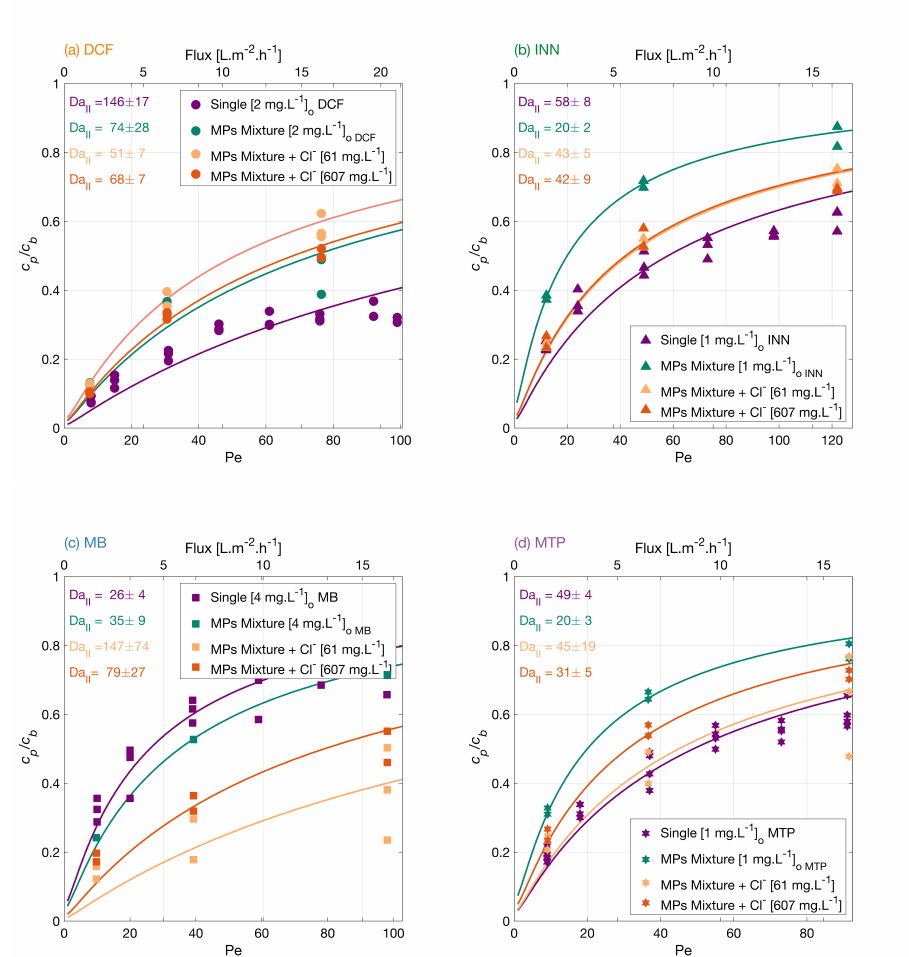
Figure 5. Degradation of ( a ) DCF, ( b ) INN, ( c ) MB, and ( d ) MTP independently, in a mixture and in a mixture with two concentrations of chloride ions. Symbols depict experimental results, and lines correspond to the mass transport and surface reaction model. Conditions: the legend shows the feed concentrations [ c b ] o , 366 nm radiation, 210 W · m − 2 and 142 mg · L − 1 Na 2 SO 4 for the experiments with the MPs independently and in a mixture, and 23.4 mg · L − 1 NaHCO 3 for the experiments with sodium